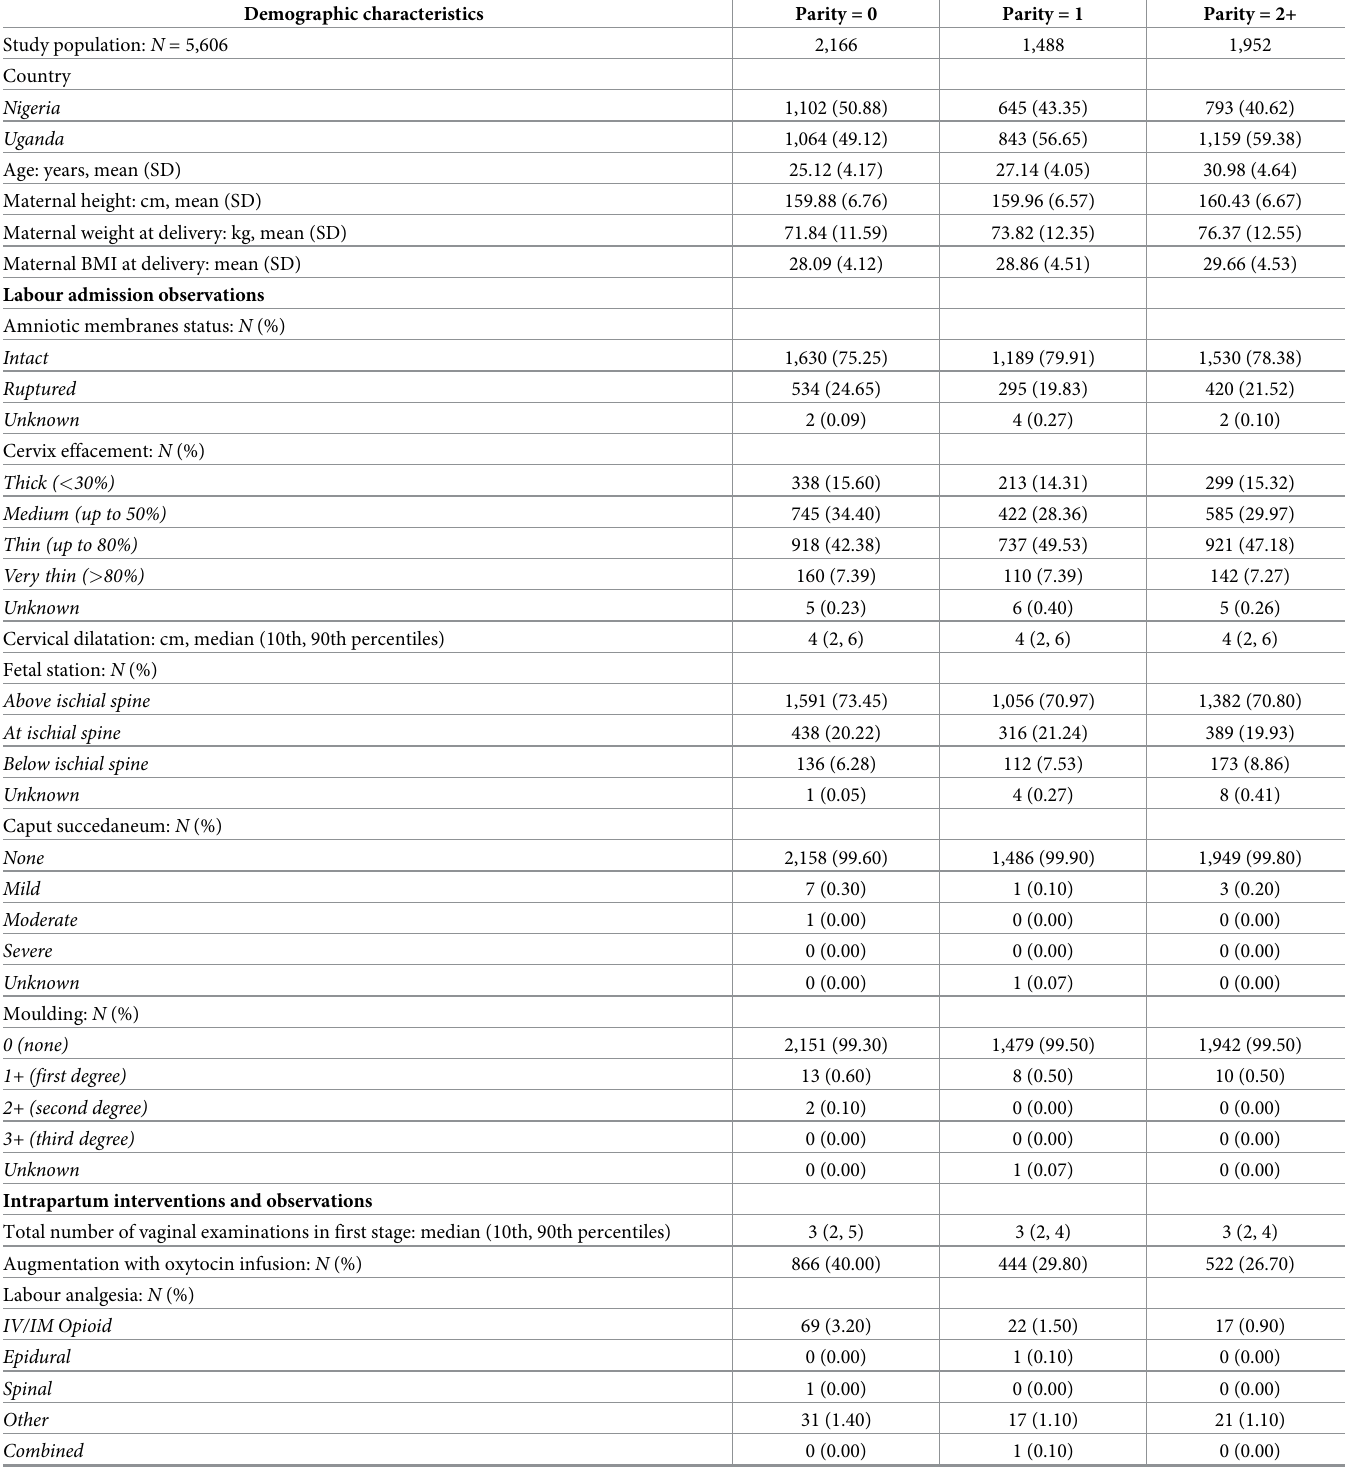
Table 1. Labour characteristics and interventions by